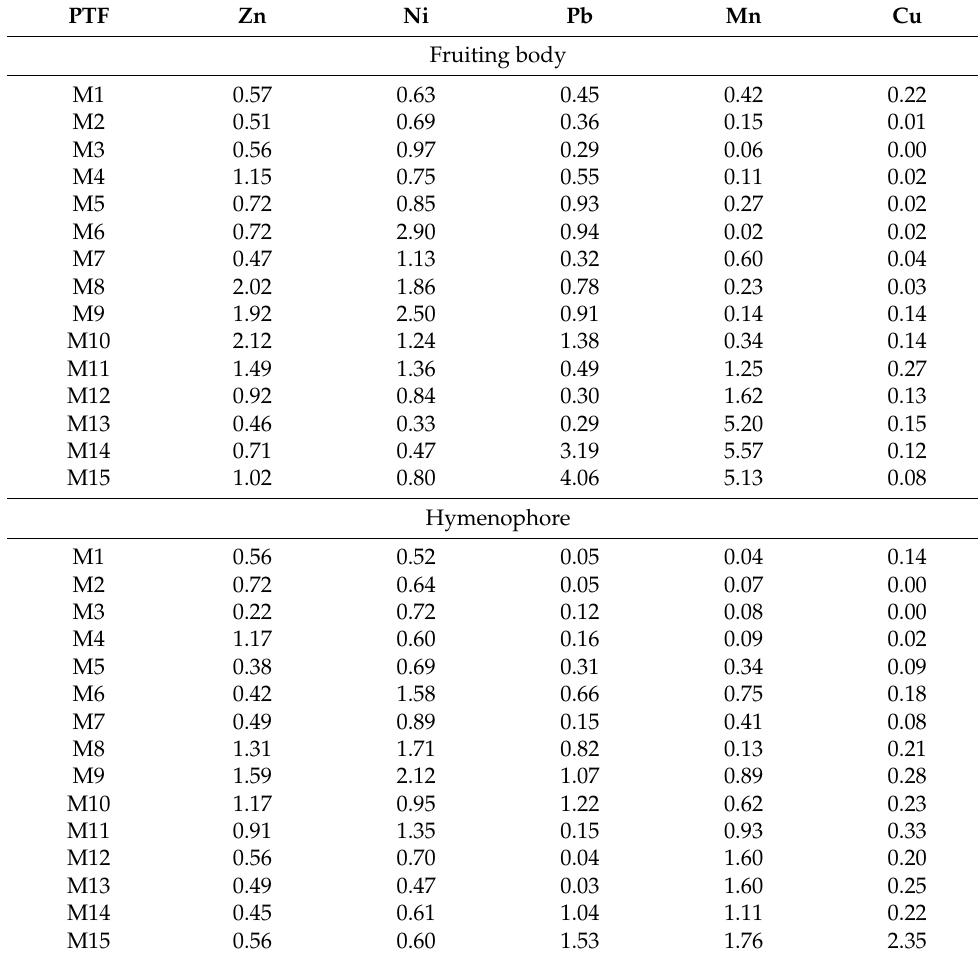
Table 4. The soil to plat transfer (PTF) of heavy metals. PTF Zn Ni Pb